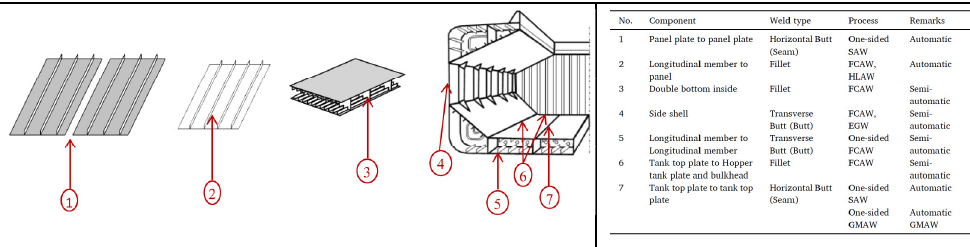
Figure 2. Typical weld types and processes in shipbuilding. Reprinted with permission from ref. [1].